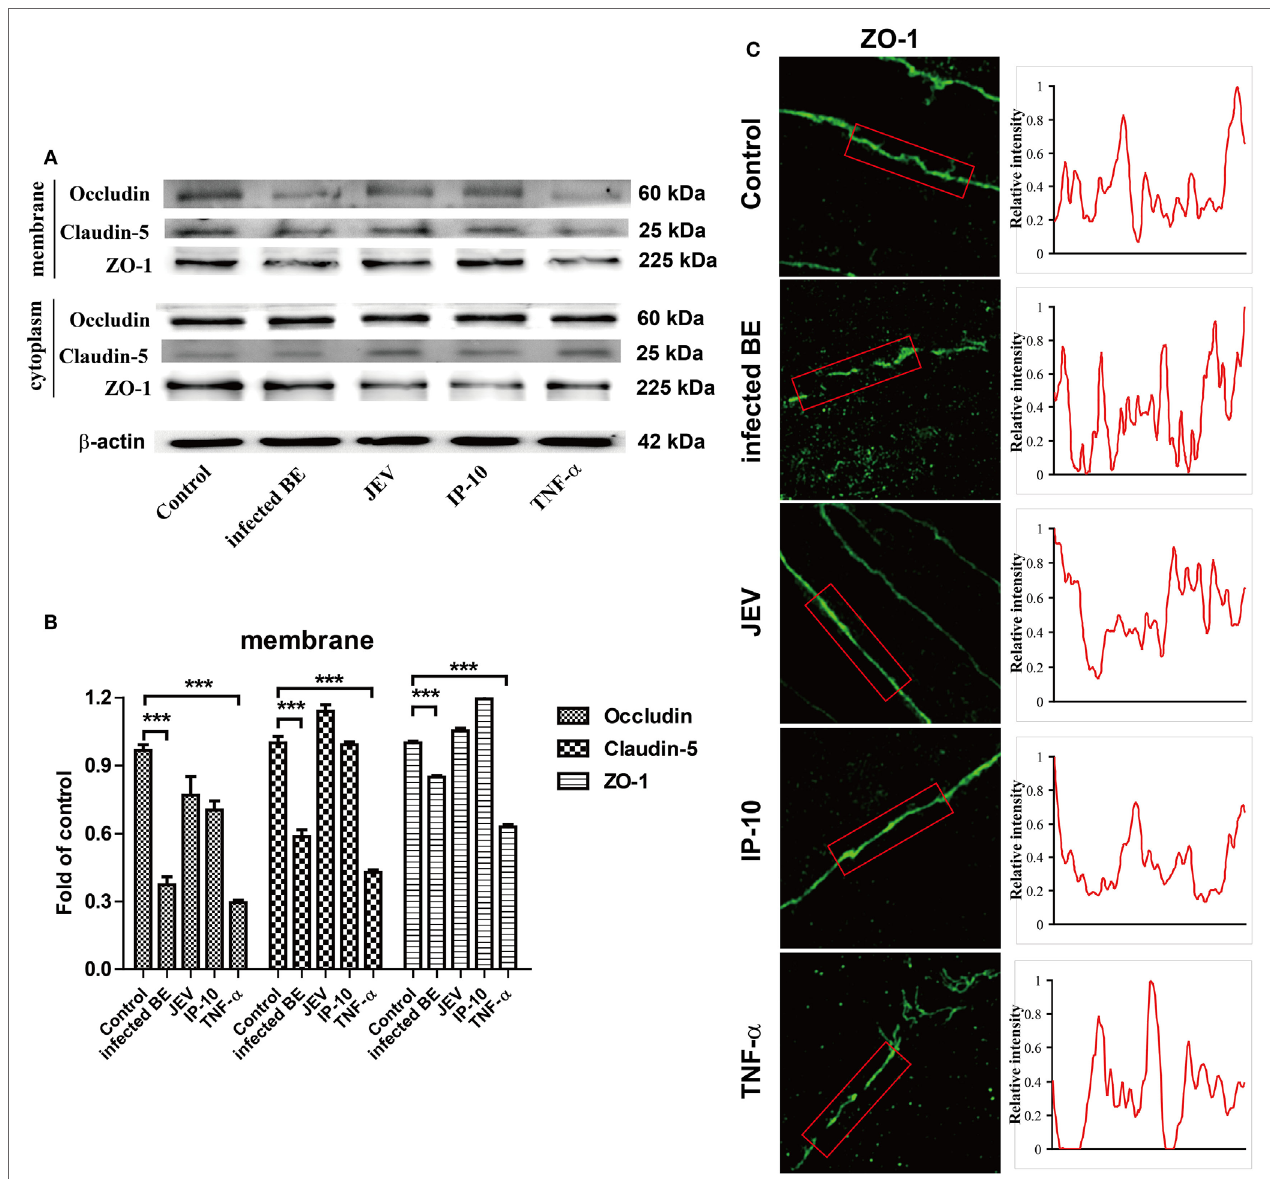
FigUre 6 | Effects of tumor necrosis factor alpha (TNF- α ) on tight junction (TJ) proteins. (a) bEnd.3 cells were treated with infected BE, Japanese encephalitis virus (JEV) (5 MOI), IP-10 (200 ng/ml), or TNF- α (100 ng/ml), and the expression of occludin, claudin-5, ZO-1, and β -actin were measured via Western blotting at 48 h. (B) The expression of TJ proteins in panel (B) were normalized to that of β -actin and quantitatively analyzed as the fold-change relative to the control. (c) The expression of ZO-1 on bEnd.3 cells after various treatments was detected by super-resolution structured illumination microscope. Relative fluorescence intensities of ZO-1 were obtained on the red box (right panel). Three independent experiments are shown as the means ± SEMs. *** p <